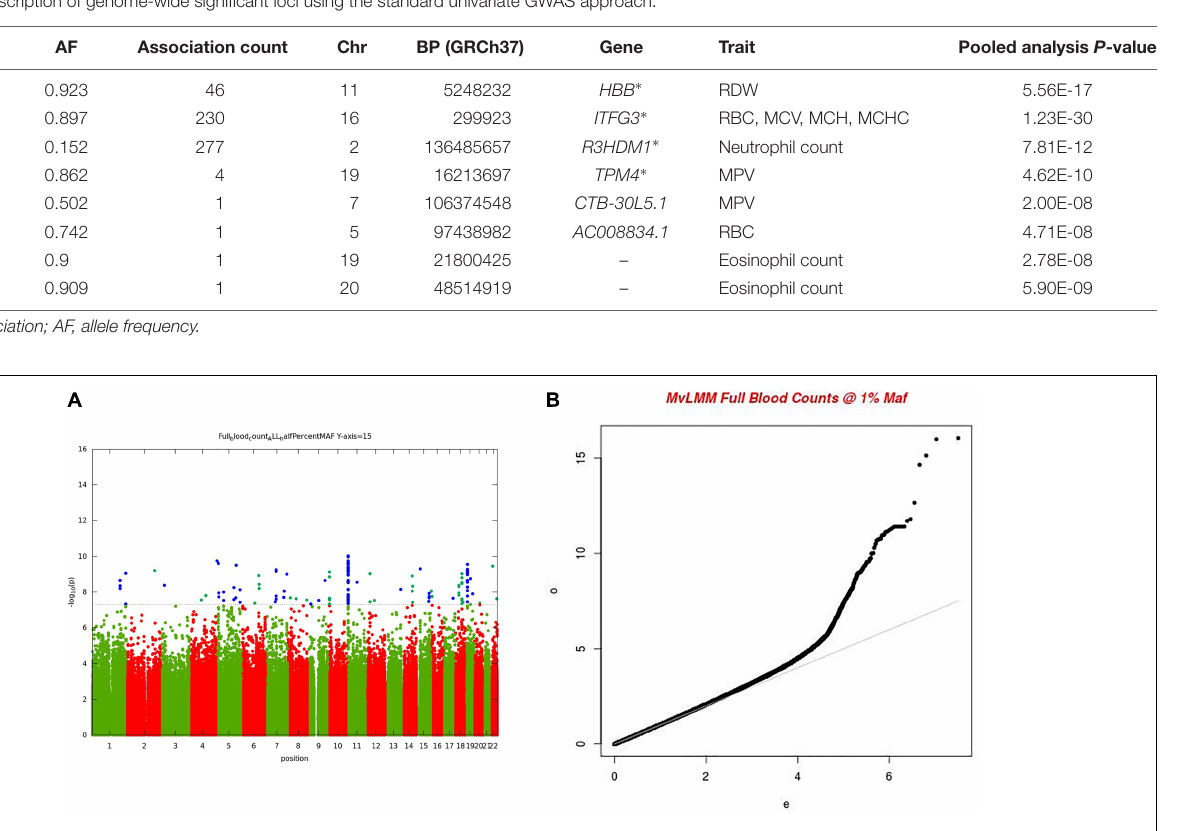
FIGURE 3 | (A) Manhattan plot of genome-wide associations for FBC (15 full blood count traits). Each point denotes a variant, with the X -axis representing the genomic position and Y -axis representing the association level -log 10 ( P -value) for the association of all variants with MAF > =0.005. The dotted line shows the genome-wide significant P -value of 5 × 10–8. (B) Visually inflated QQ plot of genome-wide associations for FBC (15 full blood count traits) with an inflation factor of